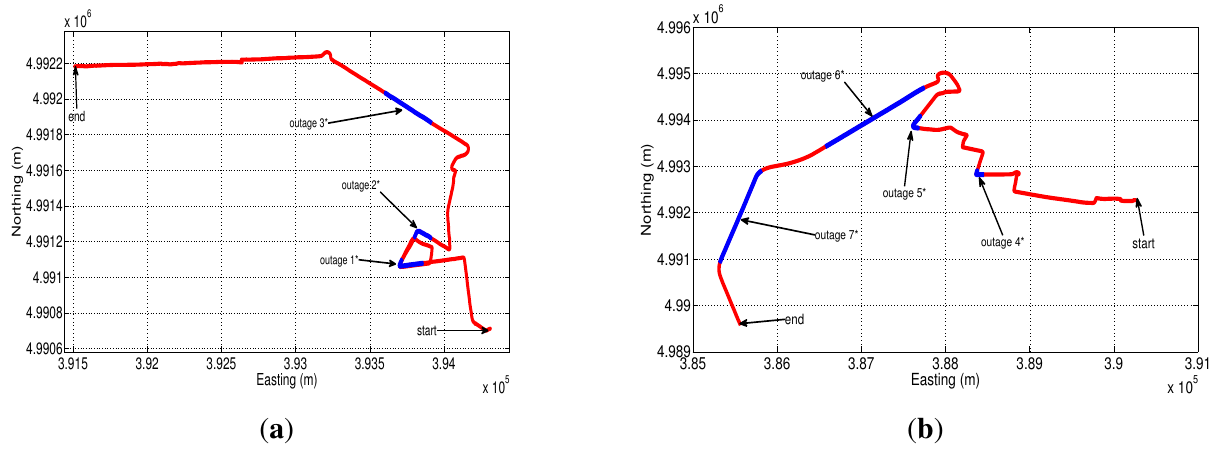
Figure 18. ( a ) First and ( b ) second trajectory test in Matlab with the GPS outages that were introduced intentionally to analyze the effect of wavelet de-nosing with different